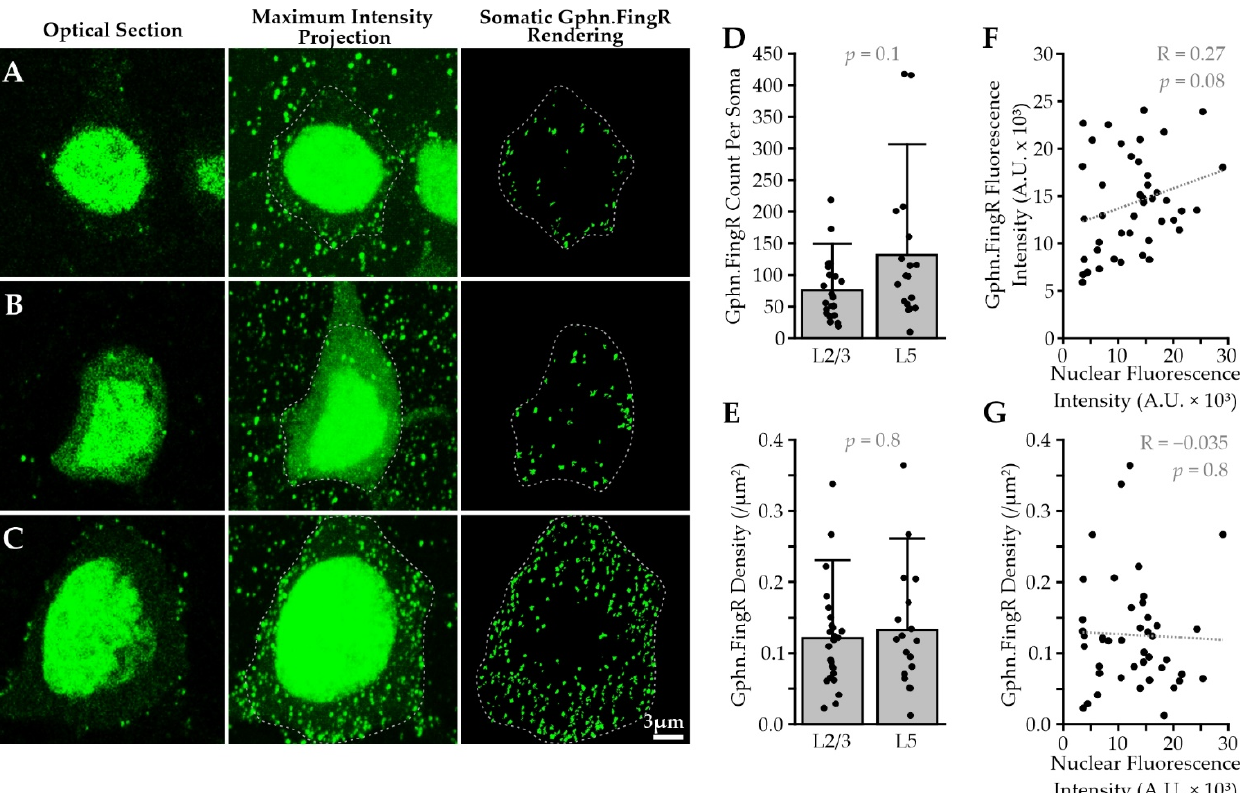
Figure 2. Neocortical Pyr neurons show heterogeneous levels of Gephyrin.FingR puncta. ( A ) From left-to-right: optical section of L2/3 Pyr neuron transduced with Gephyrin.FingR encoding AAV, maximum intensity projection of the same cell with soma outlined with a dotted grey line, 3D rendering of the cell’s somatic Gephyrin.FingR puncta (Gphn.FingR) with same dotted grey line outline overlaid; ( B , C ) as in ( A ), but for a different L2/3 and L5 Pyr neuron, respectively; ( D ) Gephyrin.FingR puncta counts per Pyr soma; ( E ) somatic Gephyrin.FingR density; ( F ) relationship between Gephyrin.FingR puncta and nuclear fluorescence; ( G ) relationship between Gephyrin.FingR density and nuclear fluorescence. Bars represent mean, error bars SDs, individual data points overlaid. L2/3: n = 23–25 cells (data from 2 cells with incomplete soma imaging were excluded from D ); L5: n = 18 cells from; N = 3 animals.